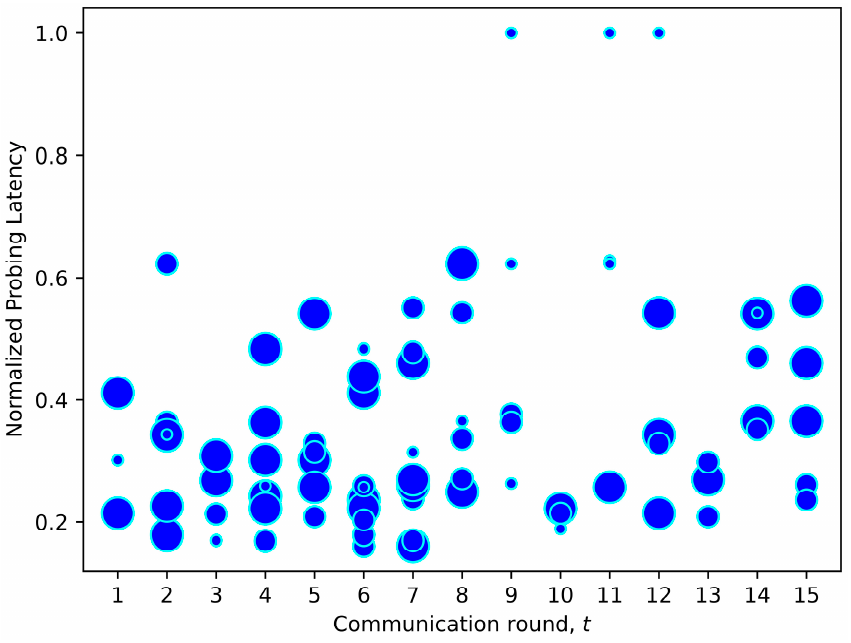
Figure 12. Local epoch count for each selected client in Figure 10. Clients with high probing latency were assigned smaller epoch counts so that the clients could finish local training earlier.